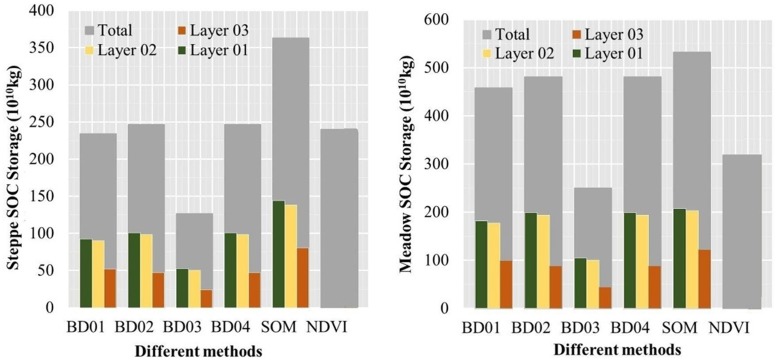
Different methods of measuring steppe and meadow grassland’s SOC storage at different soil layers (Layers1, 2, 3, and Total) on the QTP.